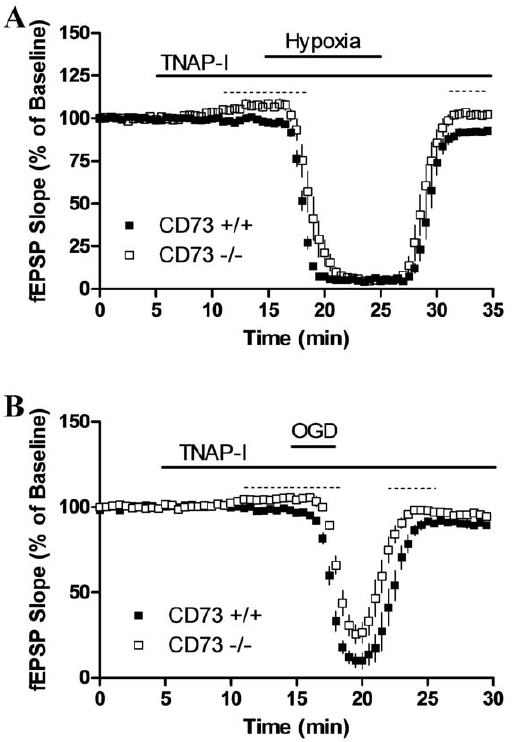
Figure 8. TNAP-I reduces oxygen-glucose deprivation (OGD)- induced decreases in fEPSP recordings from CD73 2 / 2 mice. Slices were superfused with TNAP-I as indicated by the horizontal bar and were superfused with (a) hypoxic aCSF for 10 min or (b) hypoxic glucose-free aCSF for 3 min as indicated by the second horizontal bar. n =6 CD73 + / + or 7 CD73 2 / 2 mice (a) or from n =5 CD73 + / + or 8 CD73 2 / 2 mice (b). Significant differences between genotypes are indicated by dashed lines. p , 0.05; unpaired t